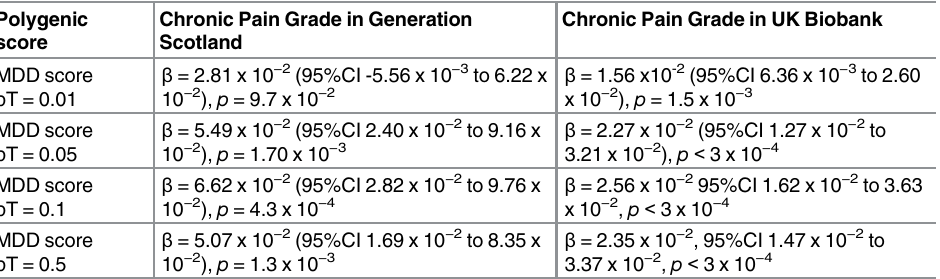
Table 4. Association between chronic pain in Generation Scotland and UK Biobank and polygenic scores for MDD derived using data from the Psychiatric Genomic Consortium. Polygenic score